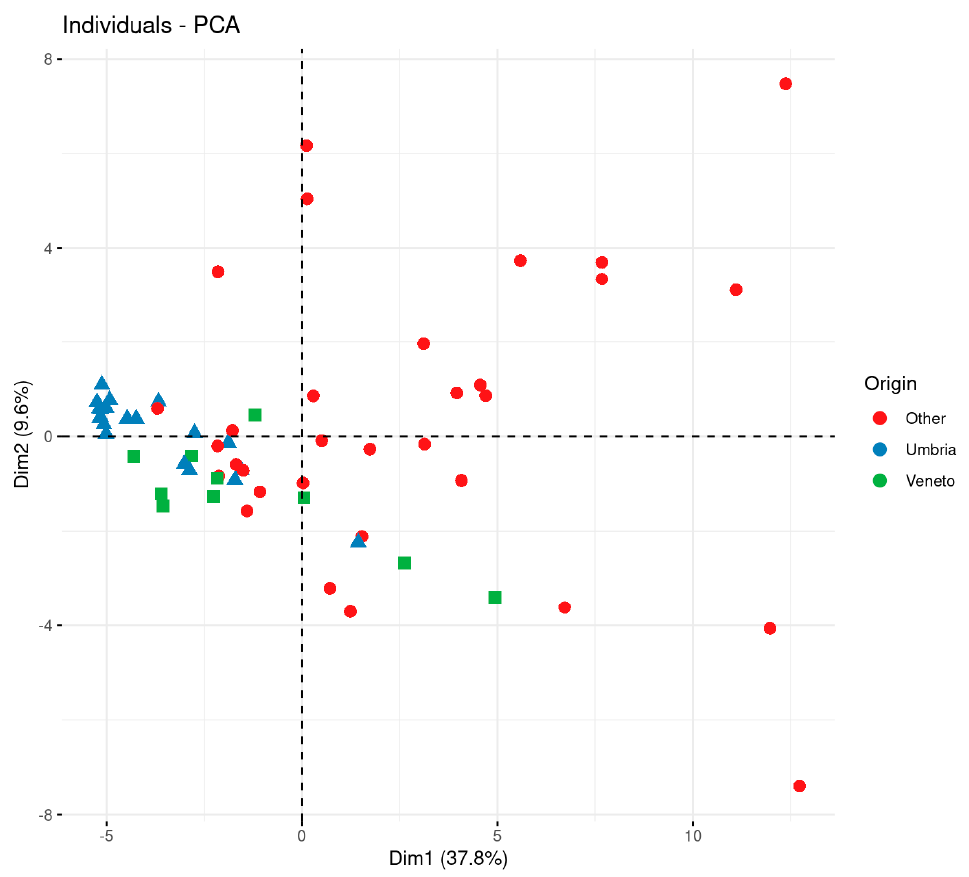
Figure 2. Score plot of principal component (PC)1 and PC2 for isotopic and elemental values of tobacco samples, according to their geographical origin (Umbria region versus other origins).